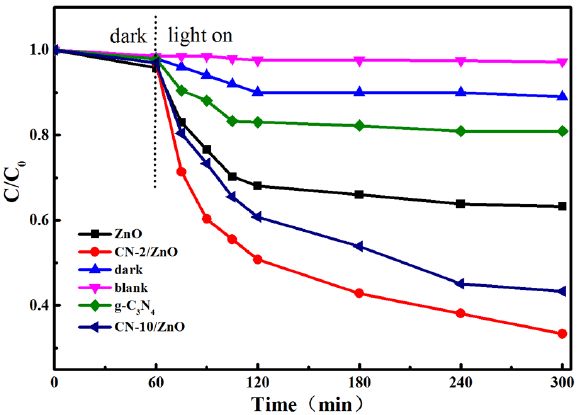
Figure 8. Photoreduction of aqueous Cr(VI) over g-C 3 N 4 , ZnO and CN/ZnO photocatalysts under visible light. C 0 and C are the initial concentration and solution concentration of scheduled irradiation intervals.